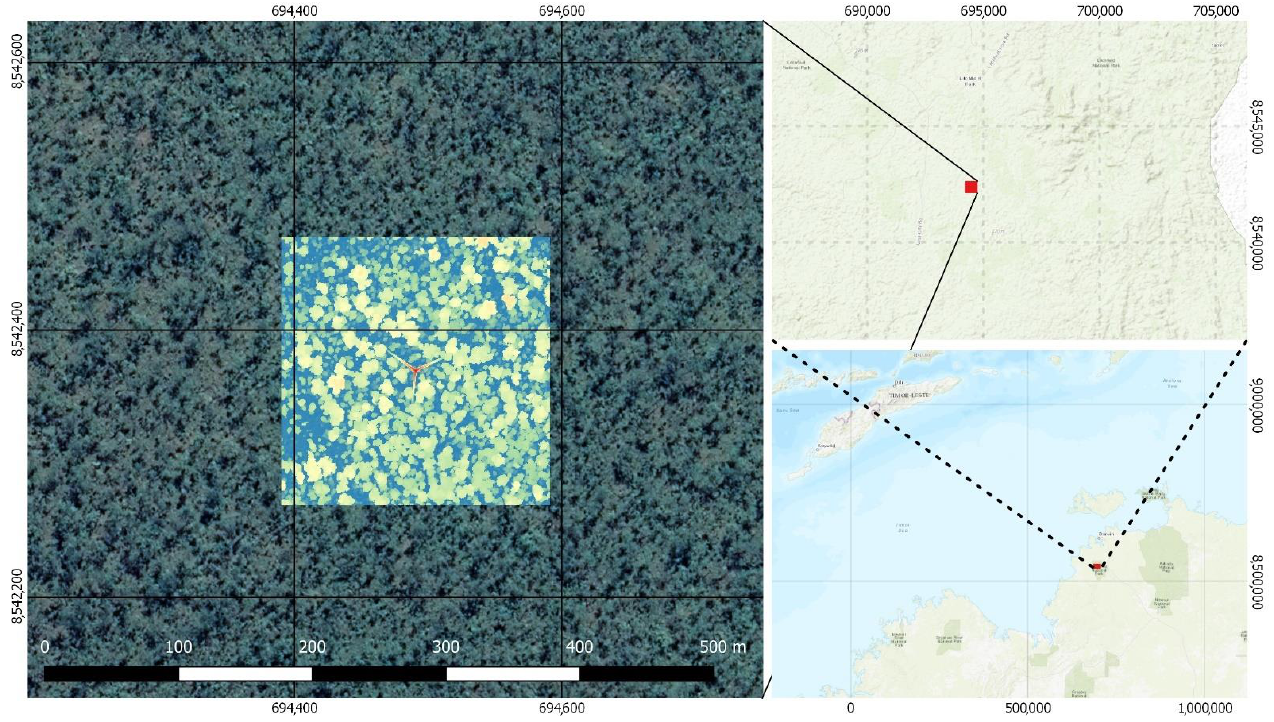
Figure 1. The Litchfield study area, located in Litchfield National Park, Northern Territory Australia. The left pane shows an aerial photograph, overlaid with the Canopy Height Model derived from the VUX-SYS dataset. The top right pane in an enhanced view of part of the Litchfield National Park. The bottom right map shows the zooms further out to Northern Australia. Coordinates on the X and Y axes are given in UTM Zone 52S.